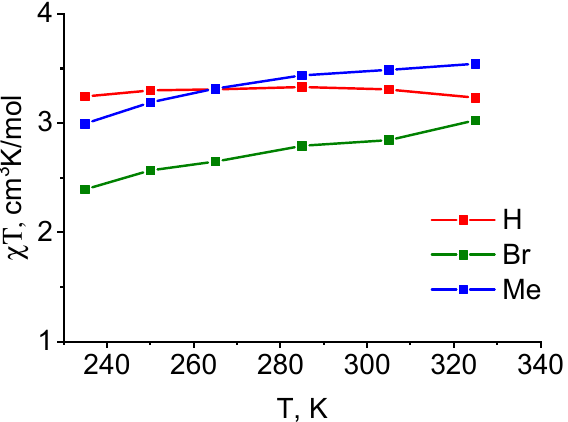
Figure 2. Variable-temperature magnetic susceptibility data for the solutions of [Fe( L R ) 2 ](ClO 4 ) 2 in acetonitrile-d 3 according to the Evans method. For [Fe( L H ) 2 ](ClO 4 ) 2 in methanol-d 4 , see Figure S2 of ESI.